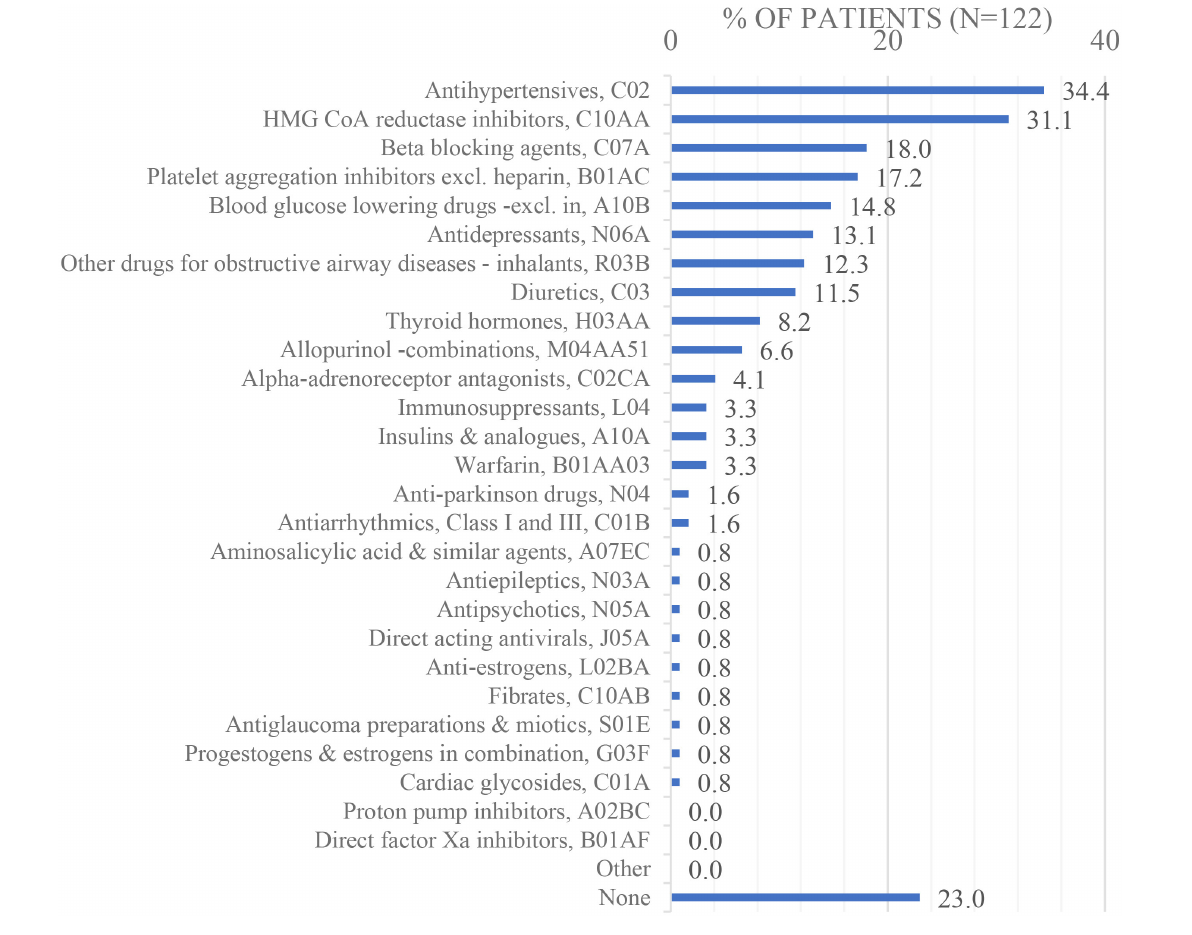
FIGURE 6 | Chronic preoperative